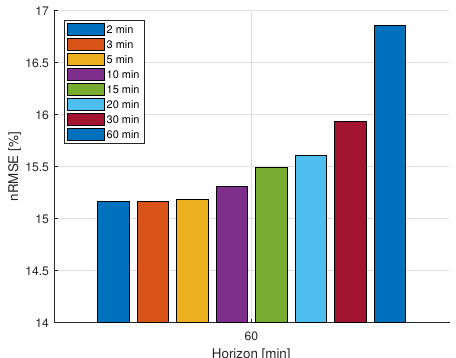
Figure 13. nRMSE at one hour for different time-steps in